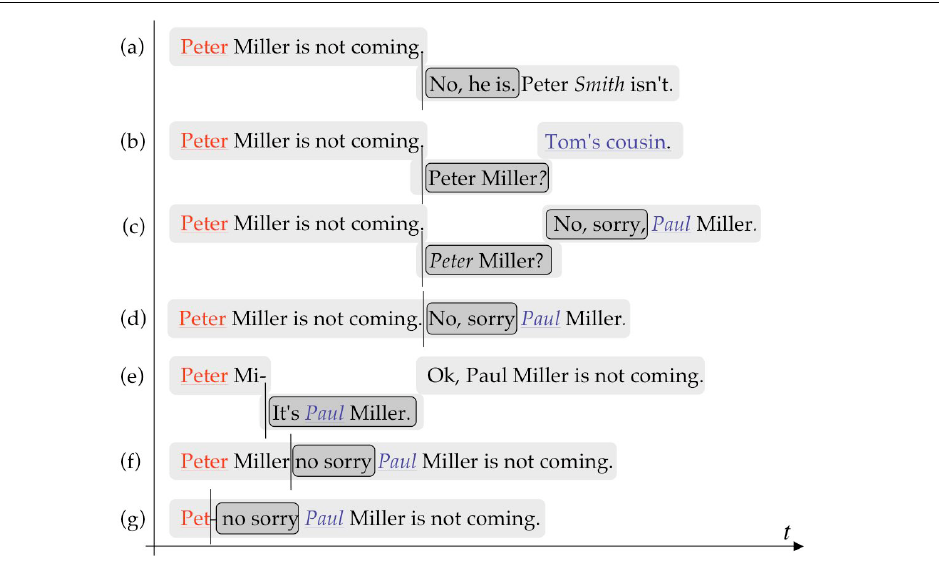
Figure 2 Continuity between (discourse) corrections and clarifications and